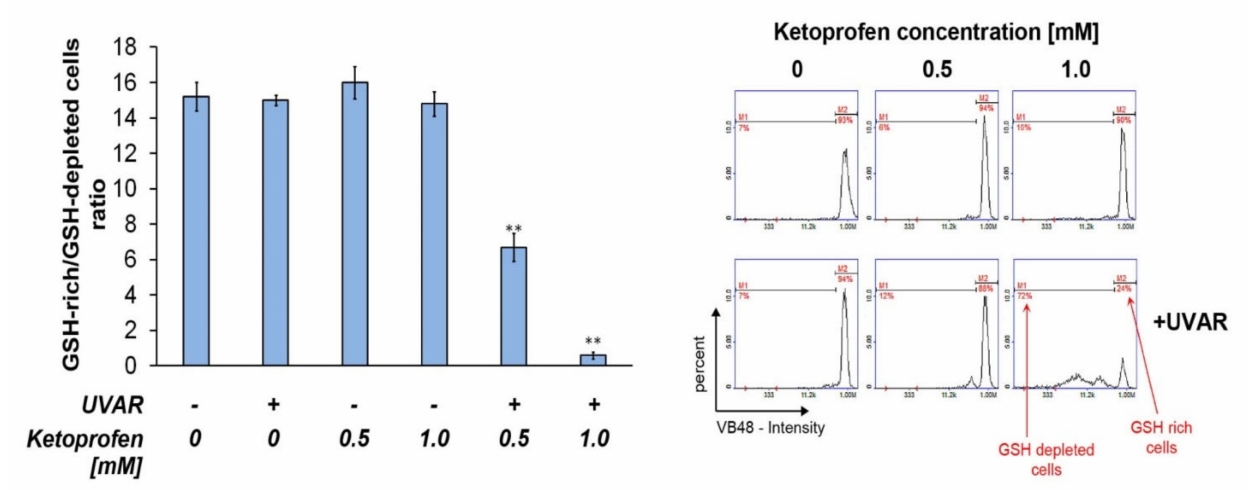
Figure 6. The co-treatment with KTP and UVAR affects the intracellular reduced thiols level in human melanotic melanoma cells. Representative scatter plots display distribution of the cell population for each tested group. Mean values ± SD of the percentage of cells with high and low level of reduced thiols are shown in the bar graphic. ** p < 0.001 vs. control (one-way ANOVA, two-way ANOVA, Tukey’s